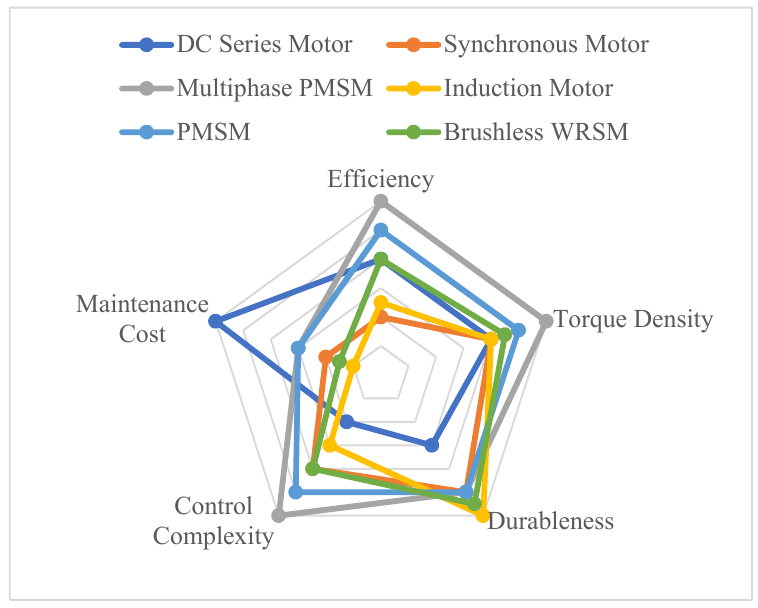
Figure 10. Spider web comparison chart of traction motors.